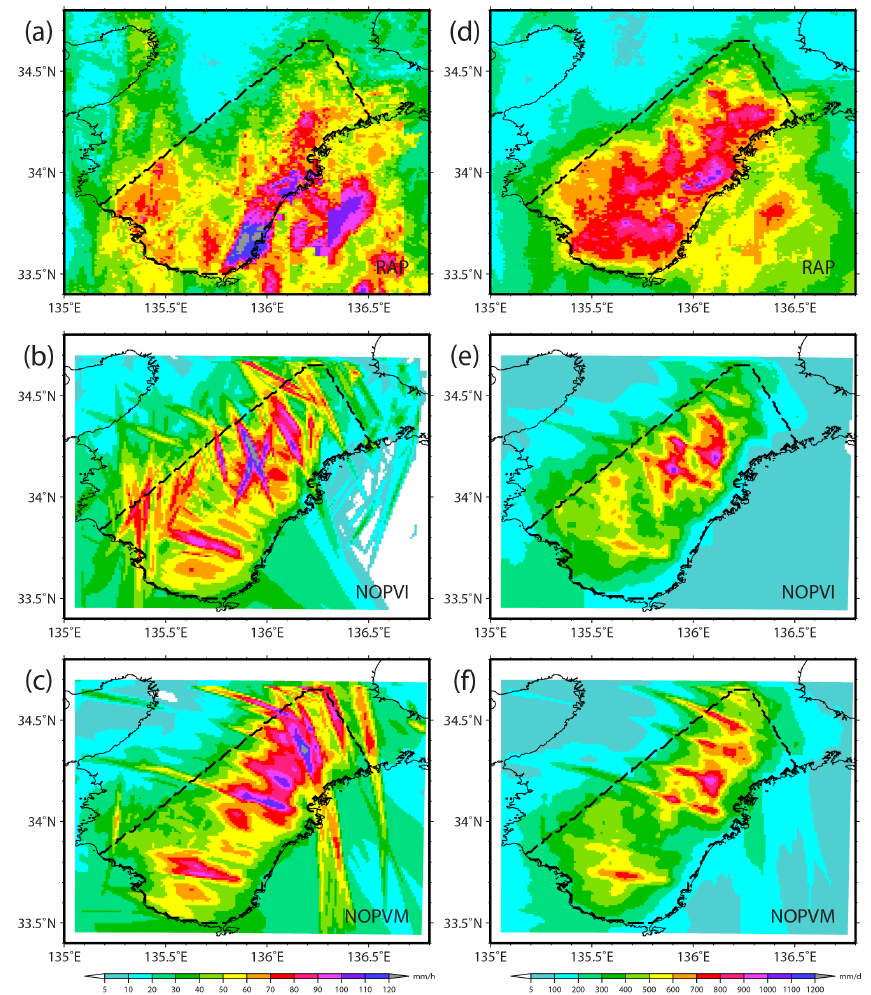
Figure 6. Horizontal distribution of RAP, NOPVI, and NOPVM rainfall amounts. (a) through (c) are the maximum hourly rainfall amounts, (d) through (f) are the maximum daily rainfall amounts. The dashed line indicates the location of the study area on the Kii Peninsula (see Fig.